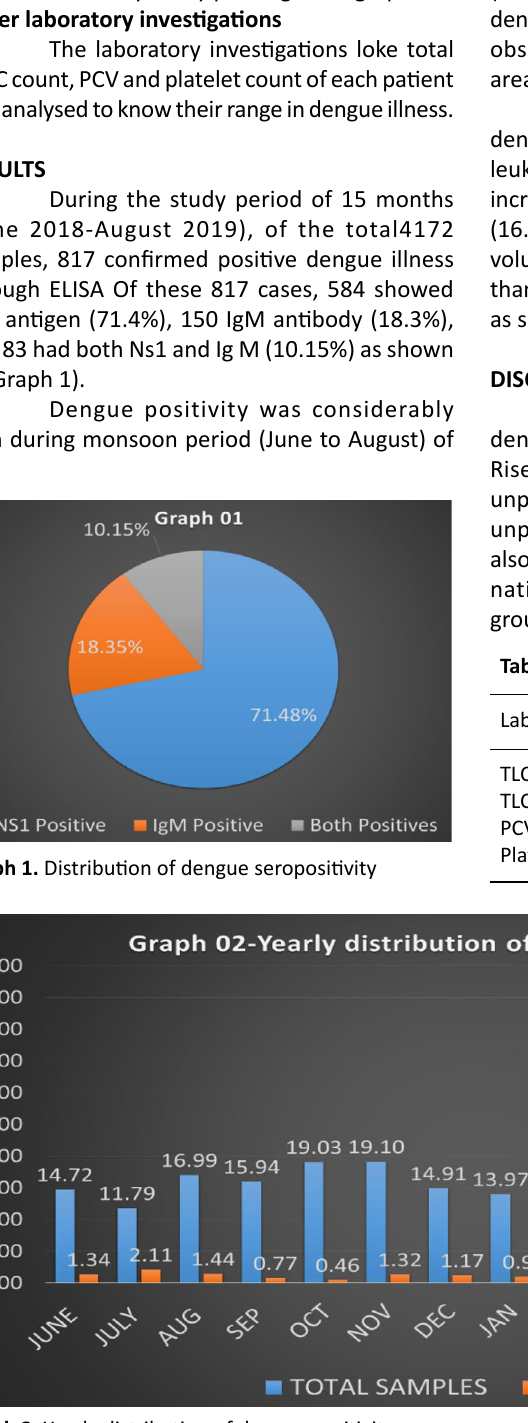
Graph 2. Yearly distribution of dengue positivity.